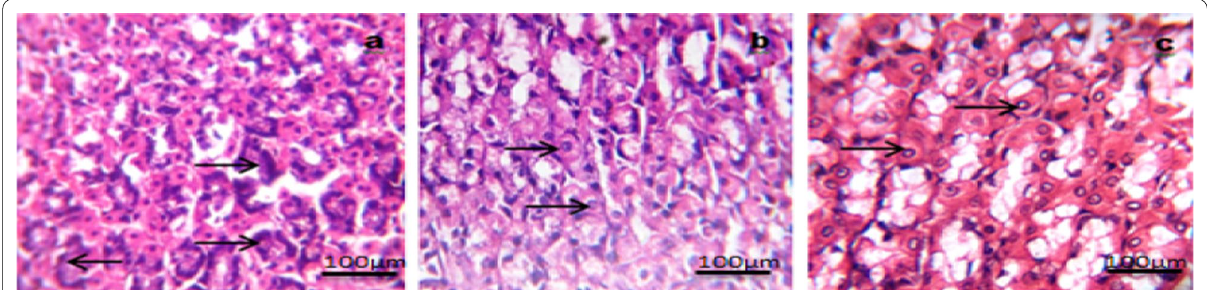
Fig. 7 Representative slides for evaluation of parietal cell numbers in the pyloric ligated stomach ulcer pretreated with folic acid and omeprazole. (H&E, X400). a Pyloric ligated stomach with no treatment. b Pyloric ligated stomach treated with Folic acid. c Pyloric ligated stomach treated with Omeprazole. Black arrow: parietal cells